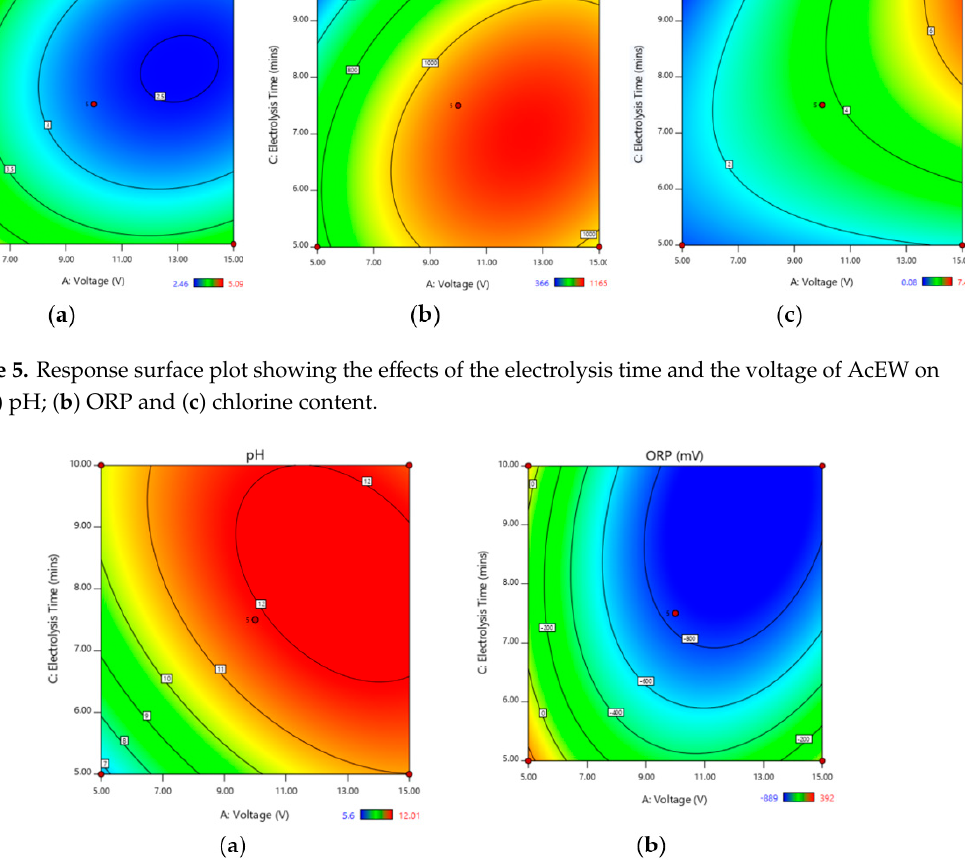
Figure 6. Response surface plot showing the effects of the electrolysis time and the voltage of AlEW on the ( a ) pH and ( b ) ORP.